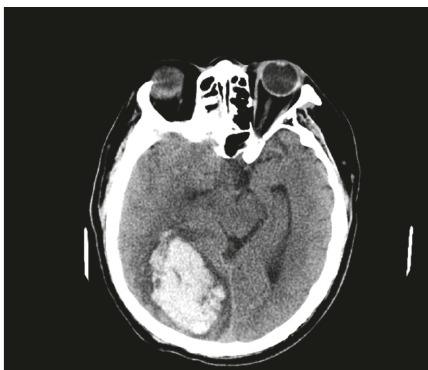
Figure 5: A contrast-enhanced MR imaging of brain performed three days after operation showed irregular mixed signal intensity on DWI with enhancement of its wall in the right occipital lobe and hyperintense lesion with small hypointense areas within in the basal ganglia